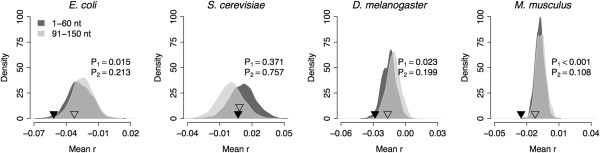
Association between weighted entropy and structural sensitivity for the 5′ end of the coding region. The solid black triangles indicate the mean correlation coefficient between these two quantities for the 5′ coding region from the first to the 60th nucleotide. The empty triangles indicate the mean correlation coefficient for the 5′ coding region from the 91st to the 150th nucleotide. The dark and light grey areas show the sampling distribution of the same quantity under the null hypothesis of no association for both regions, respectively. P1: the left-tailed P-values for the region between the 1st and the 60th nucleotide; P2: the left-tailed P-values for the region between the 91st and the 150th nucleotide.